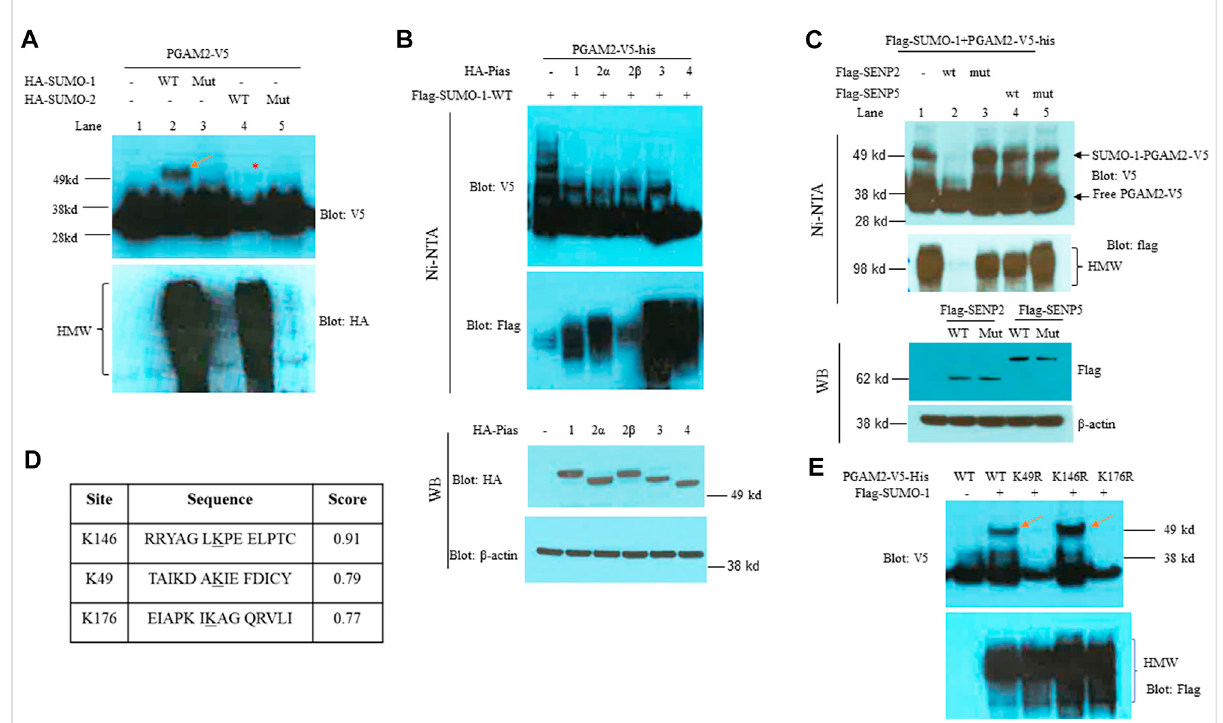
FIGURE 1 PGAM2isaSUMO-1 substratewith SUMO acceptor sitesatK49andK146. (A) ResultsofNi-NTApulldownexperiments performedinHeLacells transfectedwith PGAM2-V5-hisand oneofthefollowingexpressionvectors:HA-SUMO-1-wt, mut(i.e., de fi cient for conjugation),HA-SUMO-2-wt, or HA-SUMO-2-mut, as indicated. The top panel was probed with V5-HRP, and the bottom panel was probed with HA-HRP. Notably, the strong, slowly migrating band (red arrow) was observed only in the presence of both PGAM2-V5-his and HA-SUMO-1-wt, and the weak, slowly migrating band (red asterisk) was observed in the presence of both PGAM2-V5-his and HA-SUMO-1-wt. (B) Pias family proteins do not promote SUMOmoietyconjugationtoPGAM2.Toptwopanels:Ni-NTApulldownexperimentswereperformedinHeLacellstransfectedwithPGAM2-V5-his and fl ag-SUMO-1-wt in the presence of Pias family proteins, as indicated. Lower two panels: Western blot analysis was performed to evaluate the expression levels of HA-tagged Pias family proteins after the transfection of HeLa cells. β -actin was used as an internal control. (C)